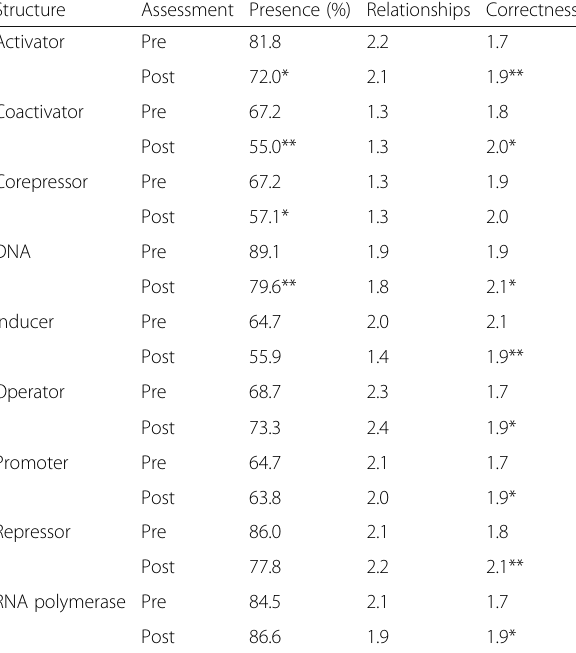
Table 2 Local environment analysis (presence, average number of relationships, and average correctness) of provided structures in students ’ conceptual models ( n = 289 students). Relationships are number of labeled arrows connected to the structure and correctness is the quality of those relationships. Models were only included in the analysis if the student created a conceptual model that contained at least 1 labeled relationship on the pre- and post-lesson activity